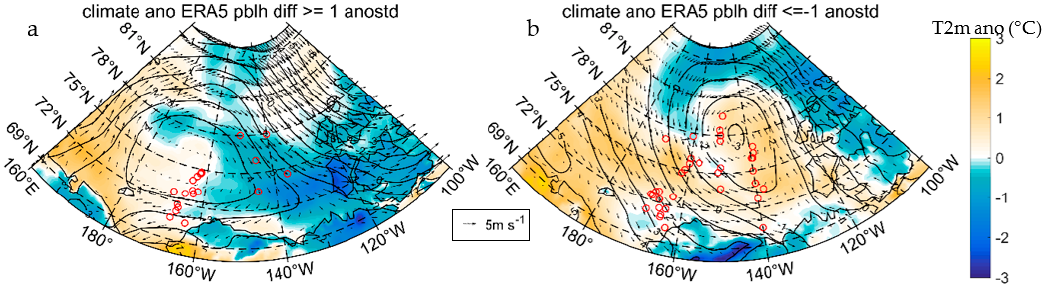
Figure 6. Anomalies of temperature (shading), sea level pressure (contours), and winds (arrows) for the times when ERA5 planetary boundary layer heights had positive biases that were greater than +1 STD ( a ) and the times when negative biases were greater than − 1 STD (values less than − 1) ( b ). The locations of the icebreaker observations with such large biases are marked by red circles.